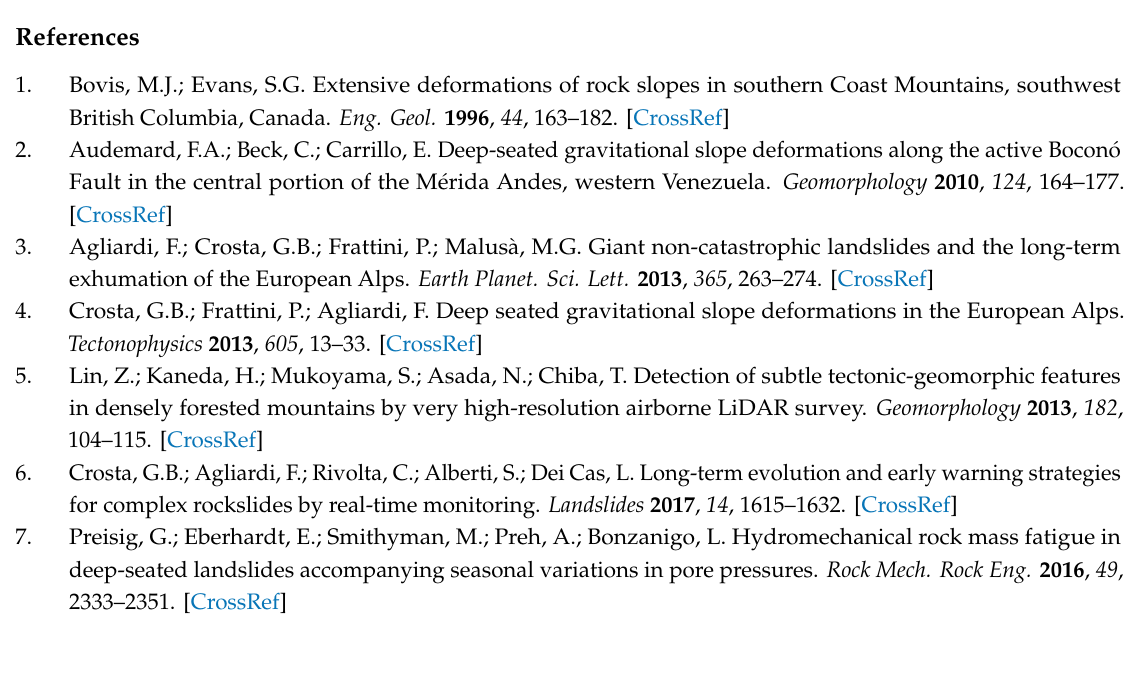
Table S1: List of images—SqueeSAR ascending dataset, Table S2: List of images—SqueeSAR descending dataset, Table S3: Interferograms derived by Sentinel-1 SLC image